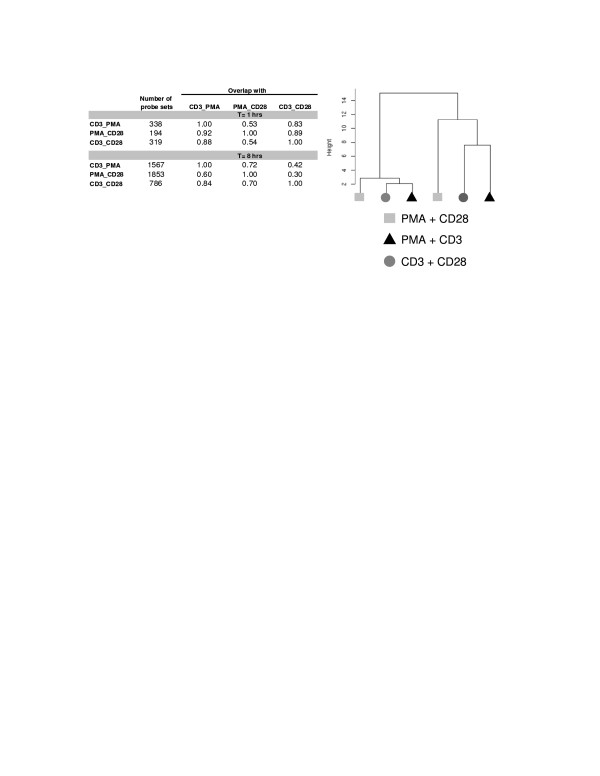
PMA/CD3 and CD3/28 stimulations differ from PMA/CD28 stimulation. The table shows the number of regulated probe sets and their overlap at 1 and 8 hrs following stimulation with CD3/PMA, PMA/CD28 and CD3/CD28 (using a fold change cut off of 2 and a p-value cut off of < 1.10-6). The right panel shows a hierarchical clustering of the data using the data for the regulated probe sets. Most of the variation is caused by the time difference (1 hr vs 8 hrs). At both time points the PMA/CD28 stimulus was clearly different from the CD3/CD28 and CD3/PMA stimulus. Repeating this analysis with different values for the fold change and p-value cut off yielded essentially the same results for the multivariate analysis.